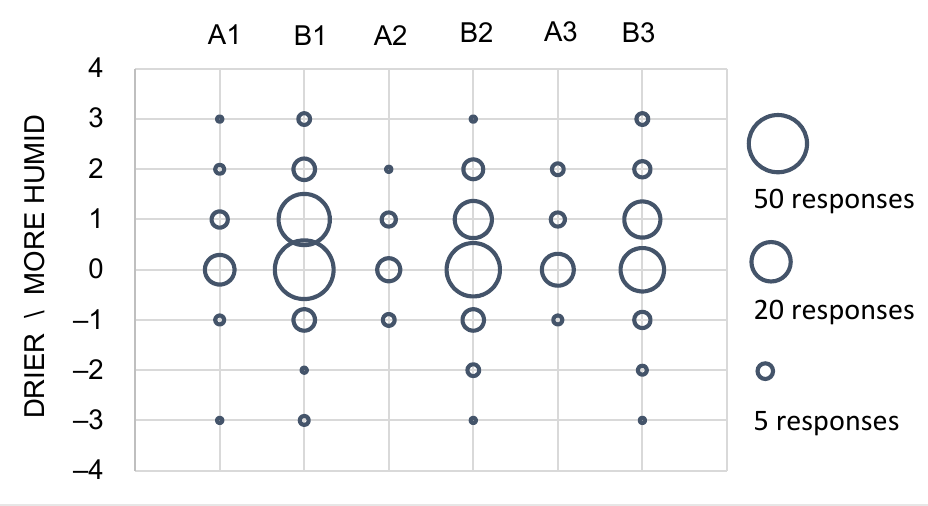
Figure 9. Relative Humidity Preference Votes distribution RHPV.